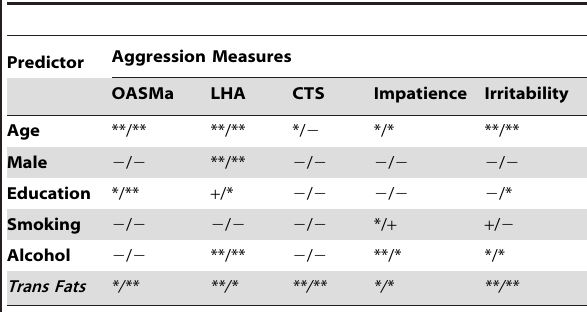
Table 3. Significance of Dietary Trans Fats Along with Other Potential Aggression Predictors in Multivariable Adjustment {